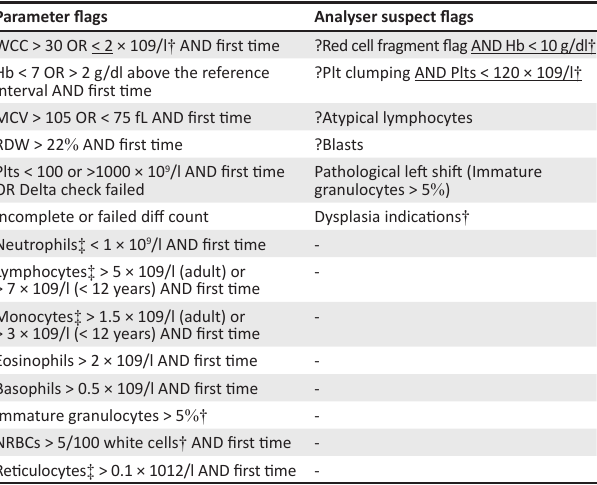
TABLE 1: Modified ICGH rules implemented at the Chris Hani Baragwanath Academic Hospital National Health Laboratory Service laboratory. Parameter flags Analyser suspect